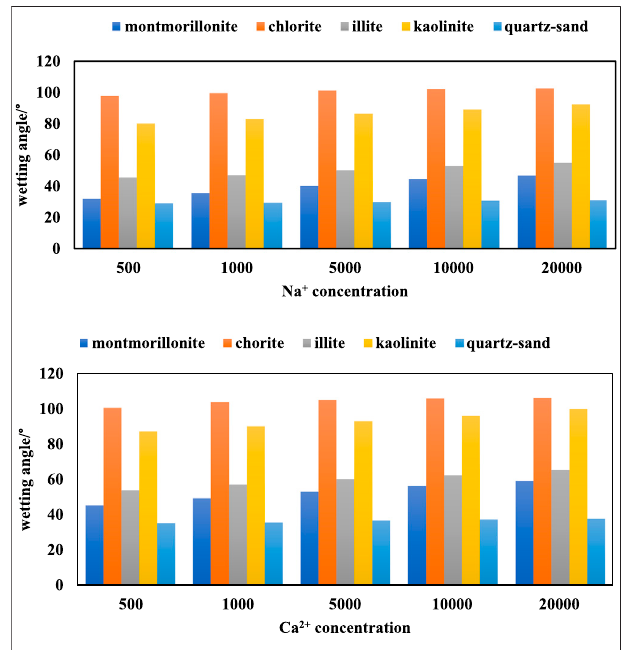
FIGURE 4 | Wetting angle of different kinds of clay